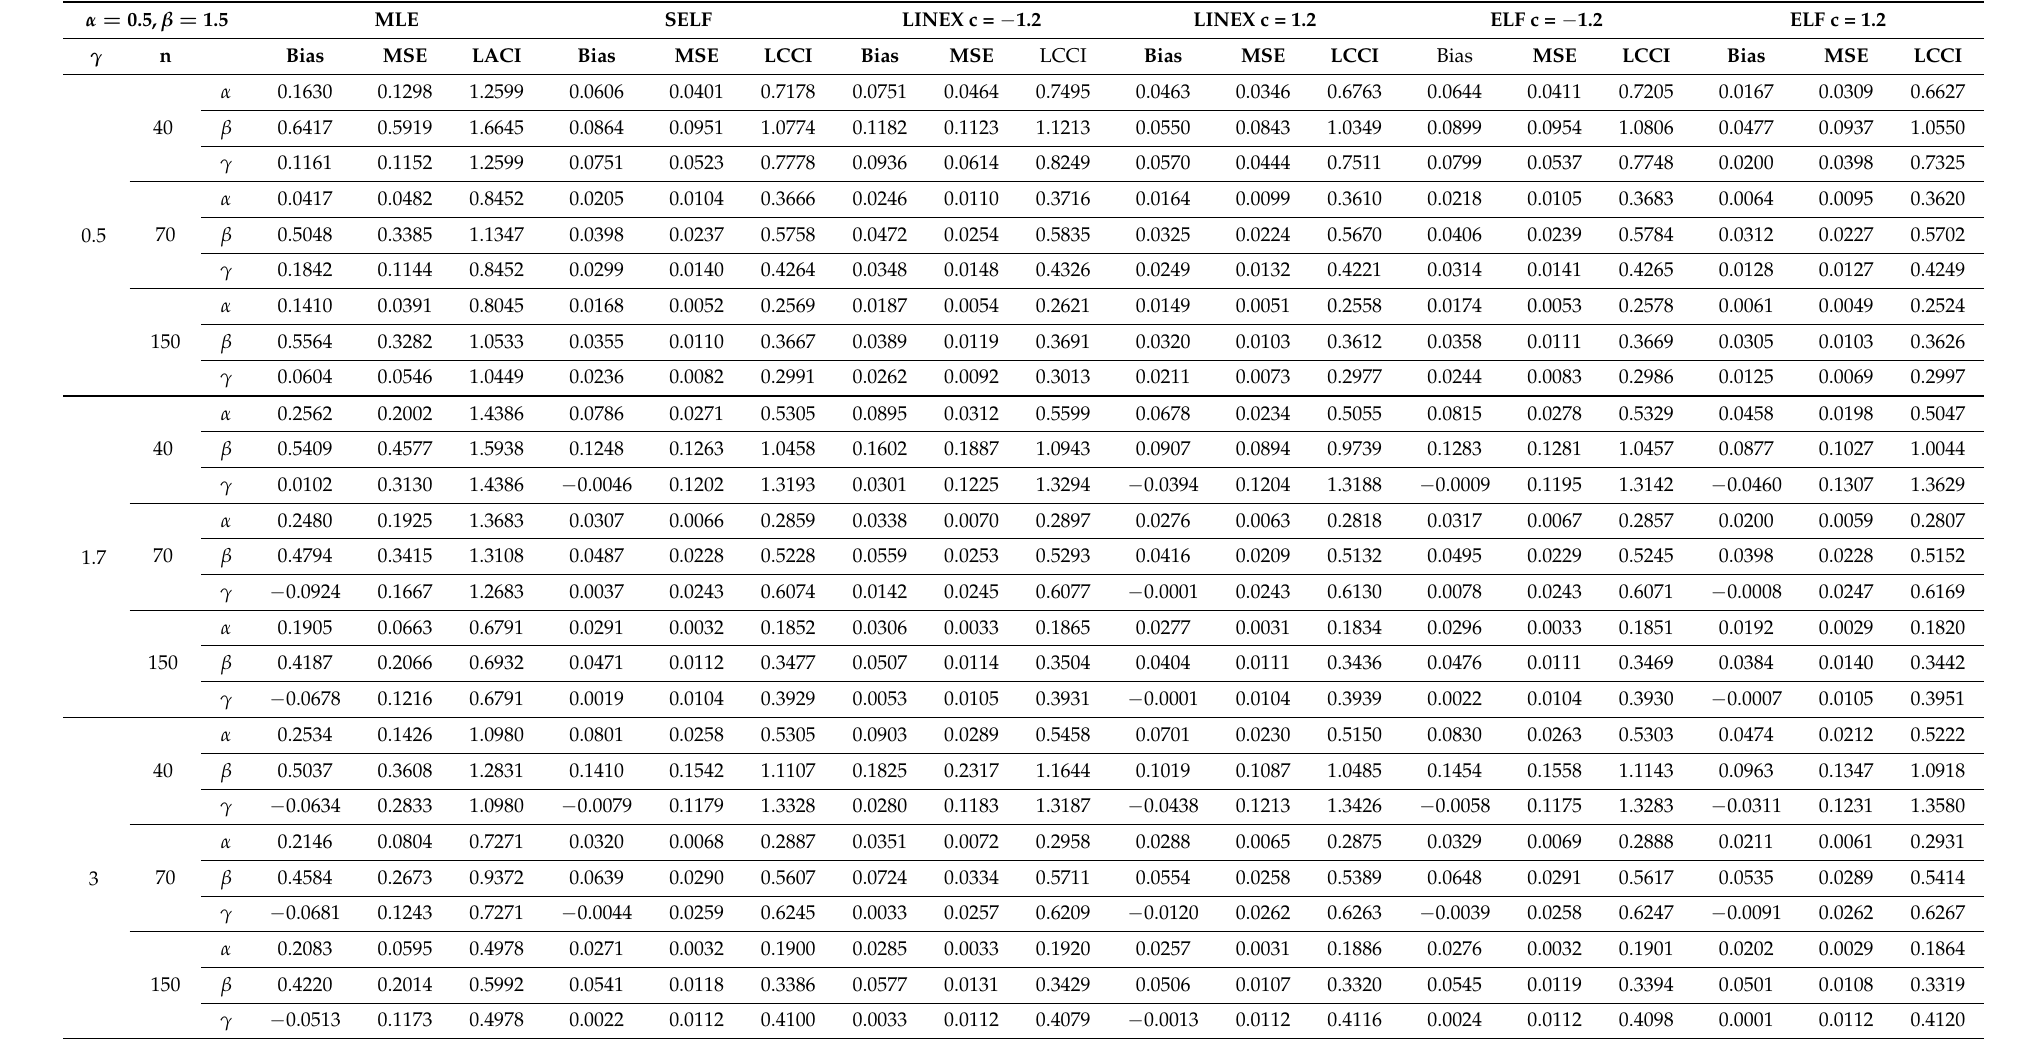
Table 4. Bias, MSE and LCI for MLE and Bayesian estimation methods for α = 0.5, β =